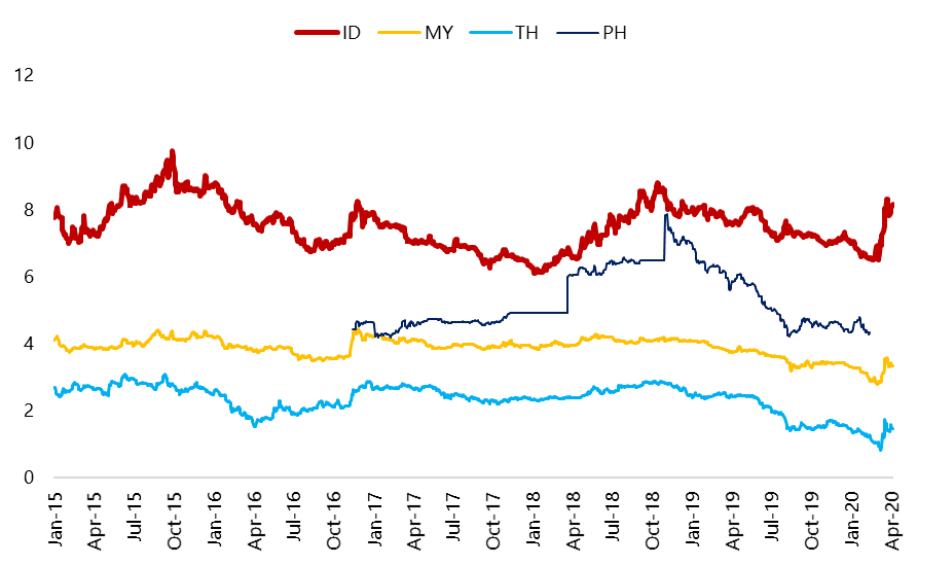
Figure 2. Government bond yield (10 years,